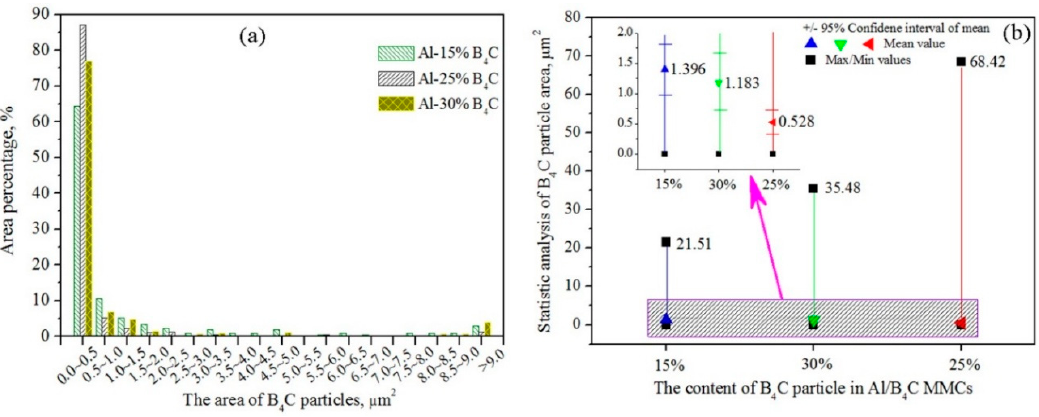
Figure 3. Statistical analysis results of the B 4 C particles in Al/B 4 C MMCs, ( a ) Area percentage and ( b ) Average area of B 4 C particles.